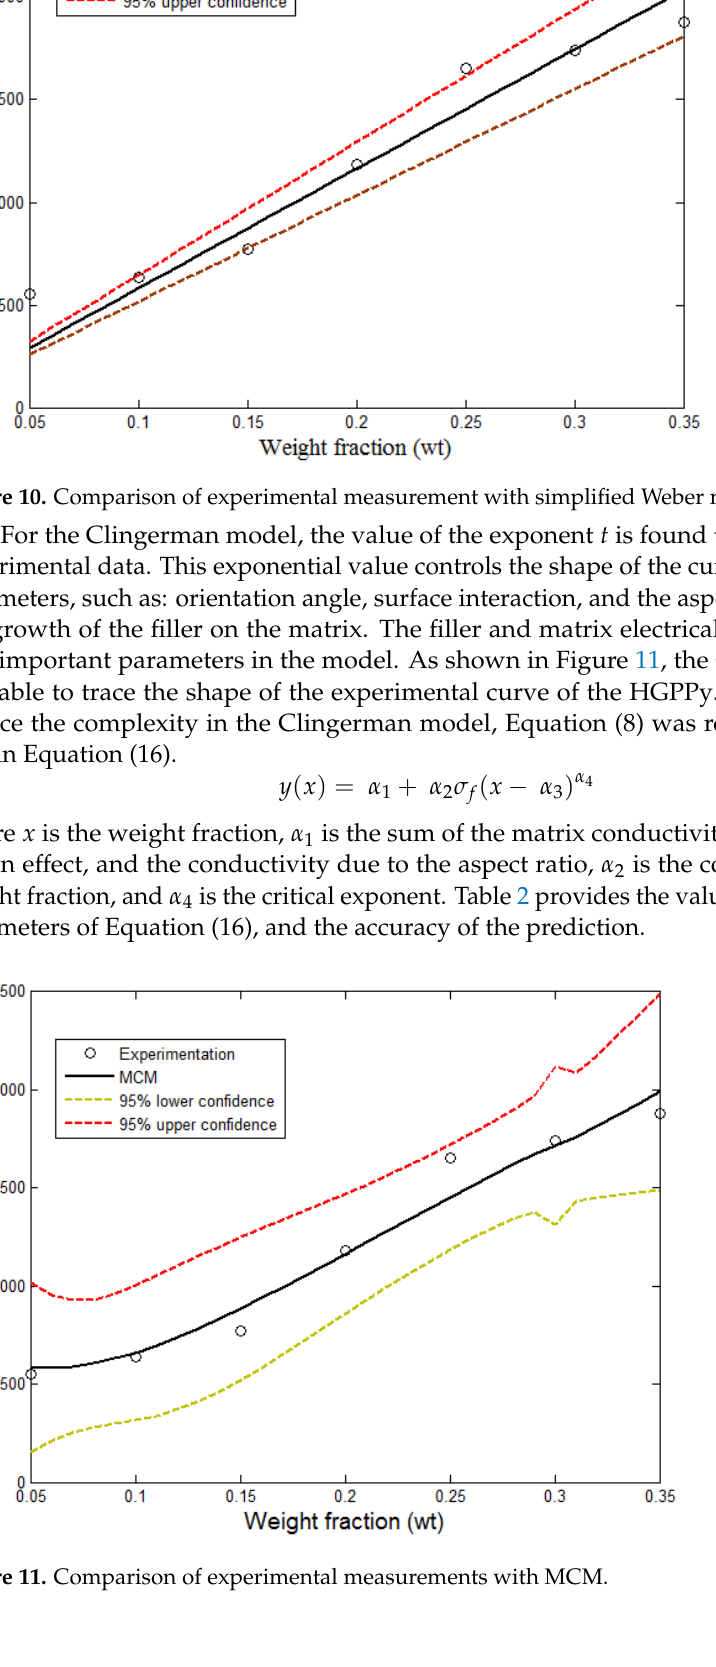
Figure 12. Comparison of experimental measurements with MTM. From the results of these models, it is obvious that models can be adopted to measure the electrical conductivity of polymer-composites if the factors which determine the elec- trical conductivity of the composites are known. As stated before, these factors include aspect ratio, filler wettability, orientation angle, surface interaction, filler morphology, in- terfacial interaction, interfacial effect, filler and matrix conductivity, and some others. For